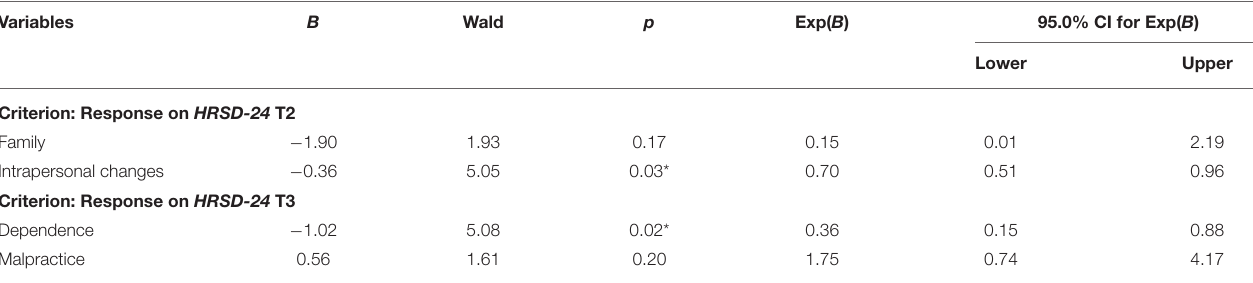
TABLE 2 | Results of the logistic regression of negative effects on treatment response at discharge (T2) and follow-up 6 months after discharge (T3) measured by Hamilton Rating Depression Scale, 24-item version (HRSD-24). Variables B Wald p Exp( B ) 95.0% CI for Exp( B )